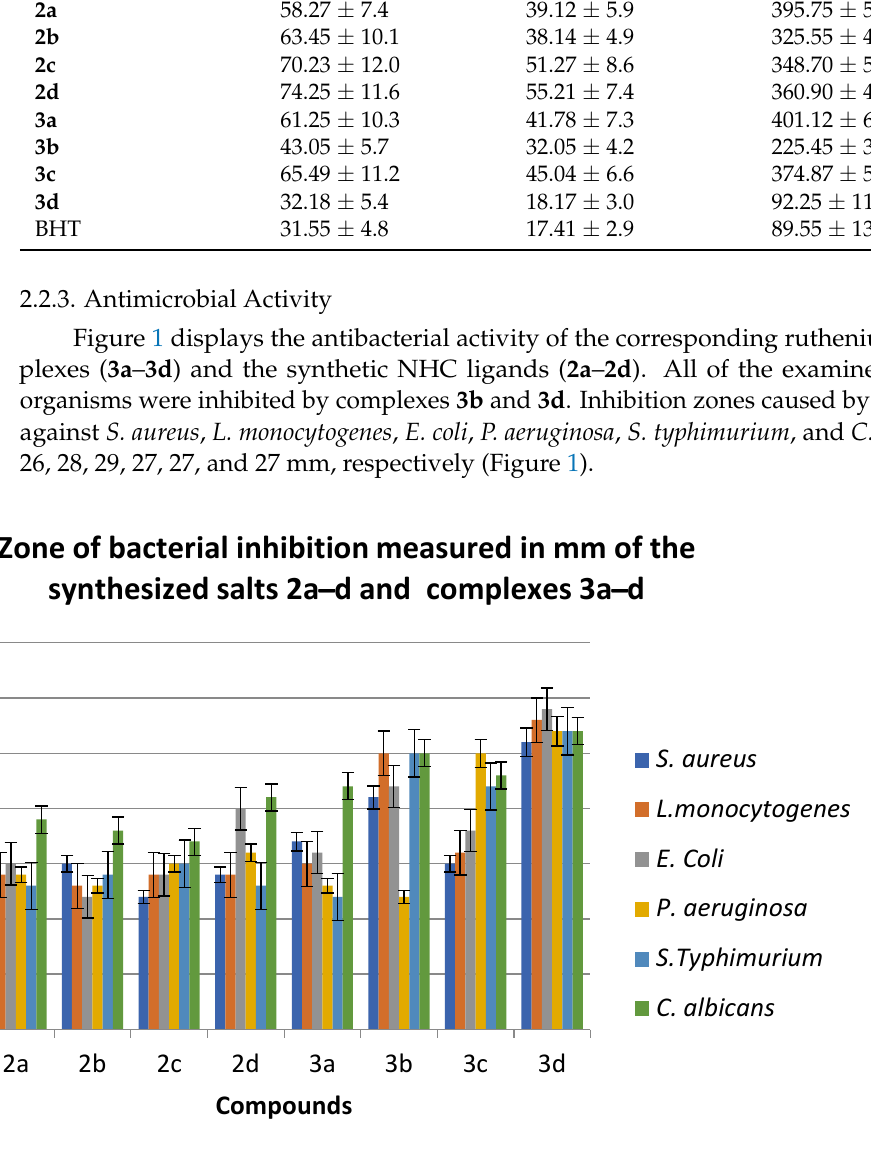
Figure 1. The antimicrobial activity of the synthesized compounds. The diameters of the inhibition zones were reported in mm. The MIC ranges from 1.95 to 62.5 µ M mL − 1 for S. aureus and S. typhimurium , from 3.9 to 62.5 µ M mL − 1 for L. monocytogenes , and from 1.25 to 31.25 µ M mL − 1 for C. albicans . Complexes 3b and 3d gave the lowest MIC values. The MIC values for synthetic